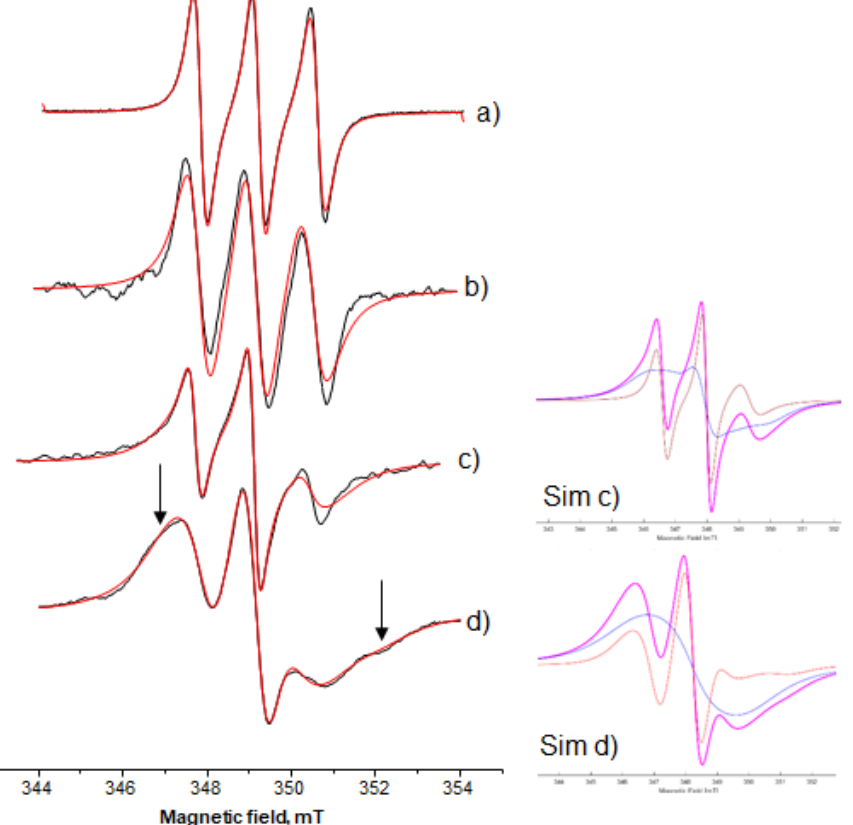
Figure 5. Ten-doxyl nonadecane (10-DND) in ( a ) AOT microemulsion w o = 15; ( b ) System A; ( c ) System B; ( d ) System C. Black line, experimental; red line, simulation. In the inserts show the simulations (violet line) of the spectra ( c ) and ( d ) (Sim (c) and Sim (d), respectively) and the analysis of its components (mobile: orange line, immobile: blue line).